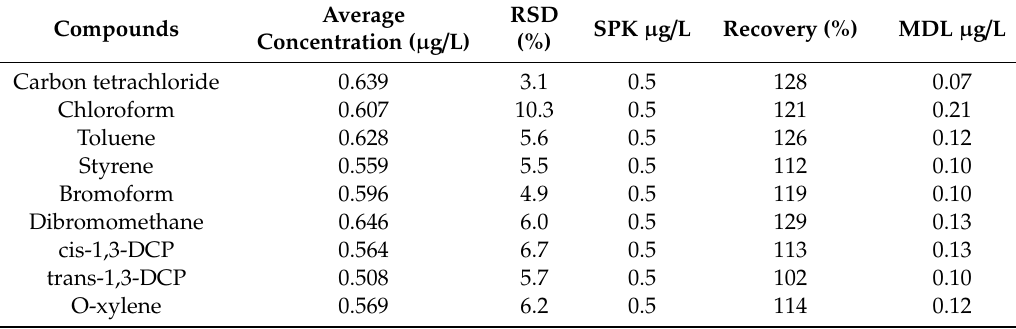
Table 3. Compounds, average concentration, % RSD, SPK µ g / L, % Recovery and MDL µ g / L.